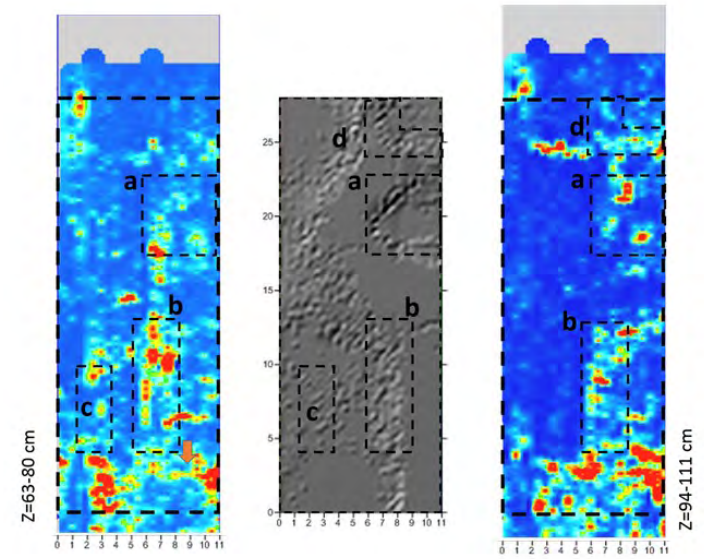
Figure 8. From left to right: georadar time slice at 63-80 cm depth, geomagnetic map and georadar time slice at 94-111 cm depth. The comparative analysis of the three maps shows a number of anomalies (indicated with letters a, b, c and d) visible from both georadar and magnetometry. In particular, the anomaly b, clearly relating to buried walls, can be observed from both the magnetic and and georadar maps, whereas other anomalies are only visible from georadar and from magnetic maps and